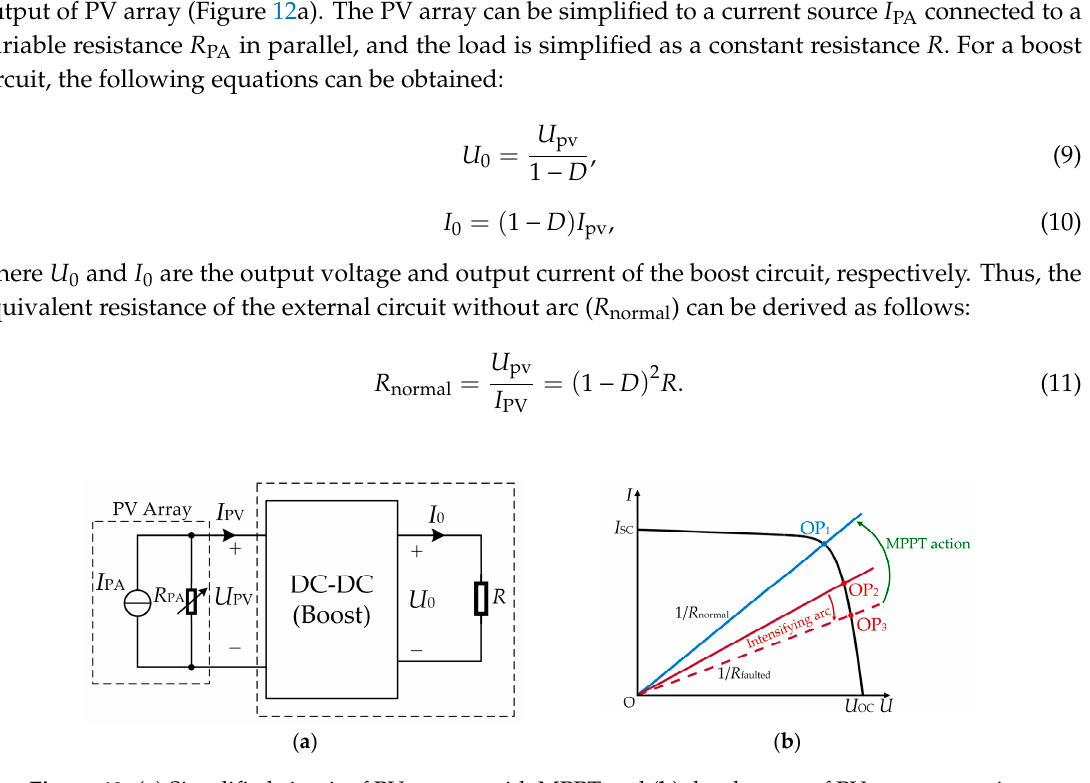
Figure 12. ( a ) Simplified circuit of PV system with MPPT and ( b ) the changes of PV array operation point in arc-fault condition.